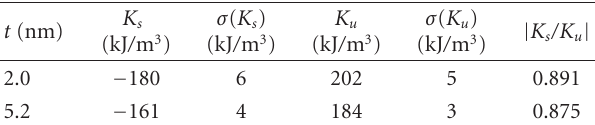
Figure 2: Same as Figure 1, but for sample 5.2nm thick. 297 data points. For clarity, the “classical” uniaxial anisotropy term is not shown. Table 1: Fitted parameters of expression